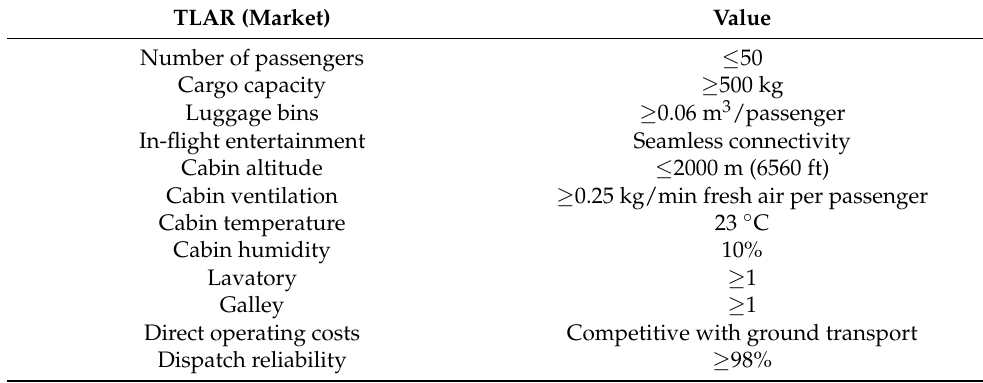
Table 2. Top-level aircraft requirements with regard to market. TLAR